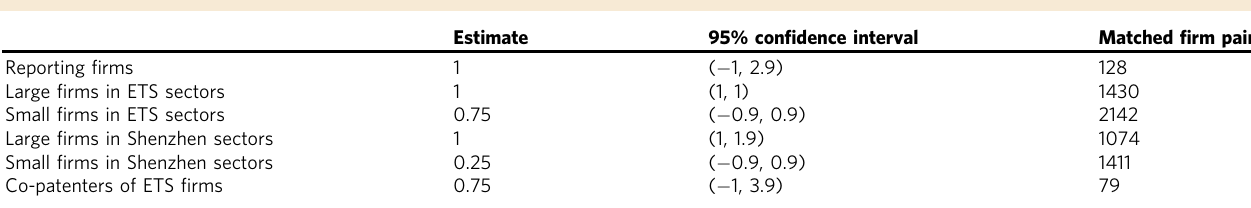
Table 1 Indirect impact of the ETS on non-ETS fi rms